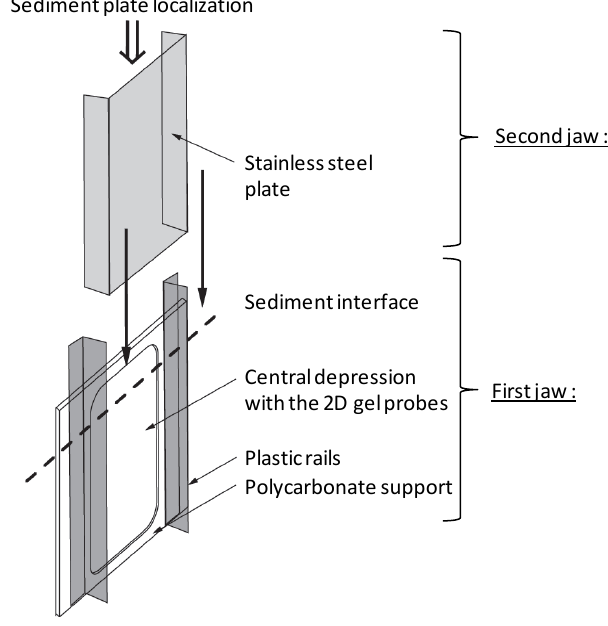
Figure 1. Schematic view of the “jaw device” for simultaneous sampling of sediment and